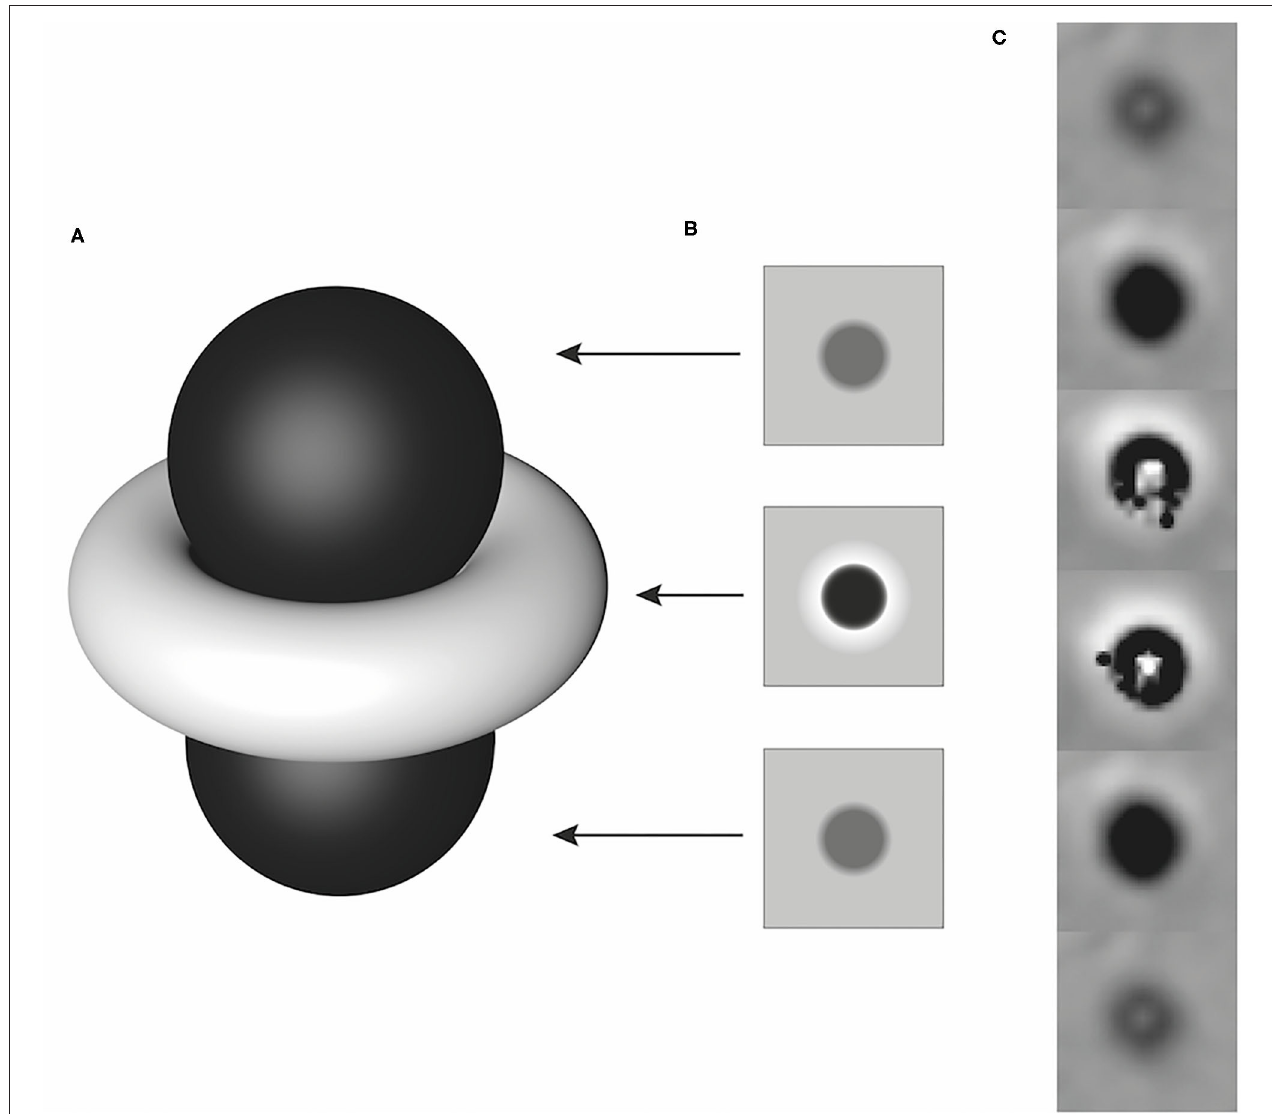
FIGURE 1 | Schematic illustration of a dipole artifact (A) with simulated phase images corresponding to the local field distribution in planes above, at the equator, and below the paramagnetic lesion (B) and an example of its representation of a paramagnetic lesion in a right-handed system over several consecutive slices (C) . Modified according to Deistung et al.